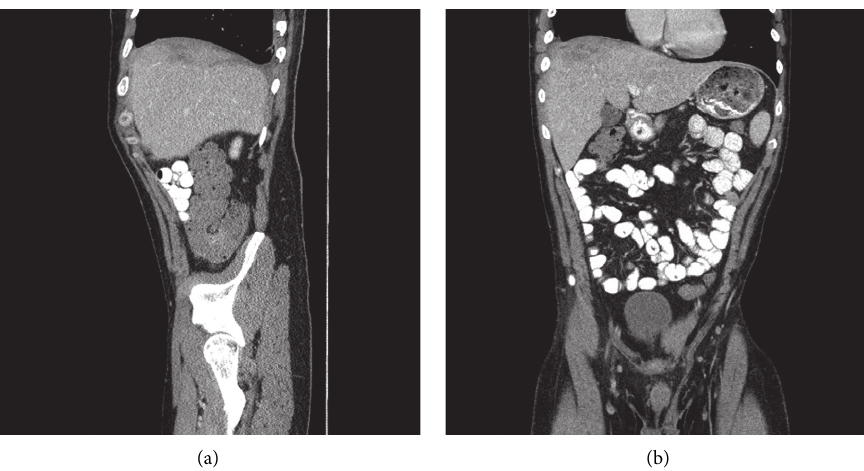
Figure 2: CT chest/abdomen/pelvis with contrast, sagittal view (a) and coronal view (b), 57 days after hospital admission, showing resolution of hepatic